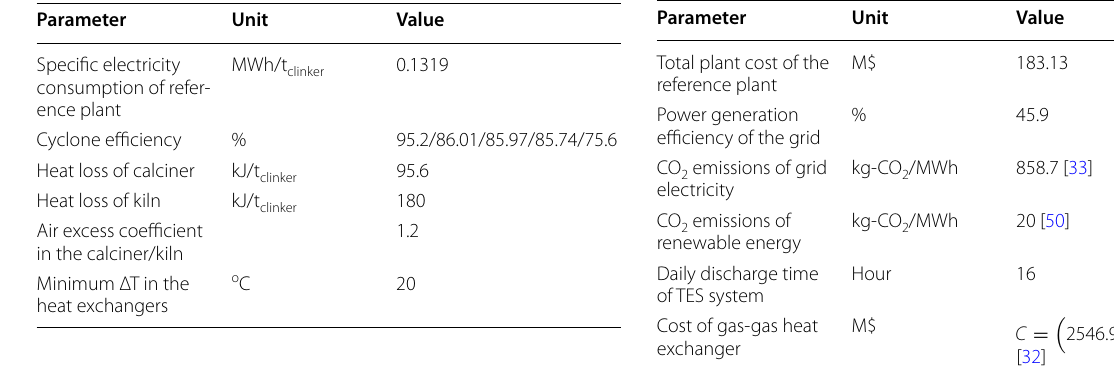
Table 3 Model assumptions for process simulation Table 4 Model assumptions for economic assessment [22]